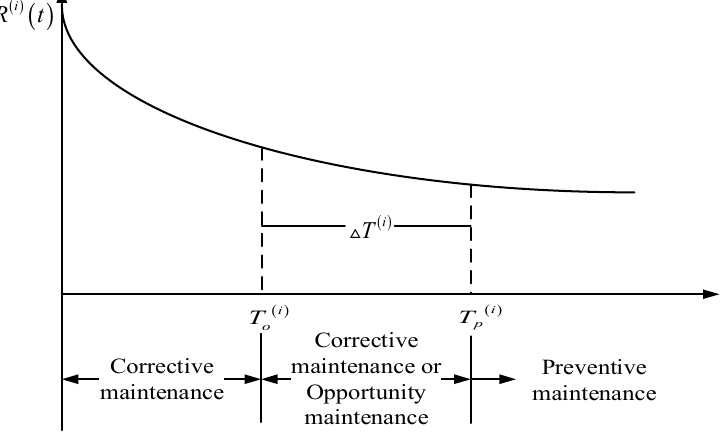
Figure 7. Opportunistic maintenance strategy.